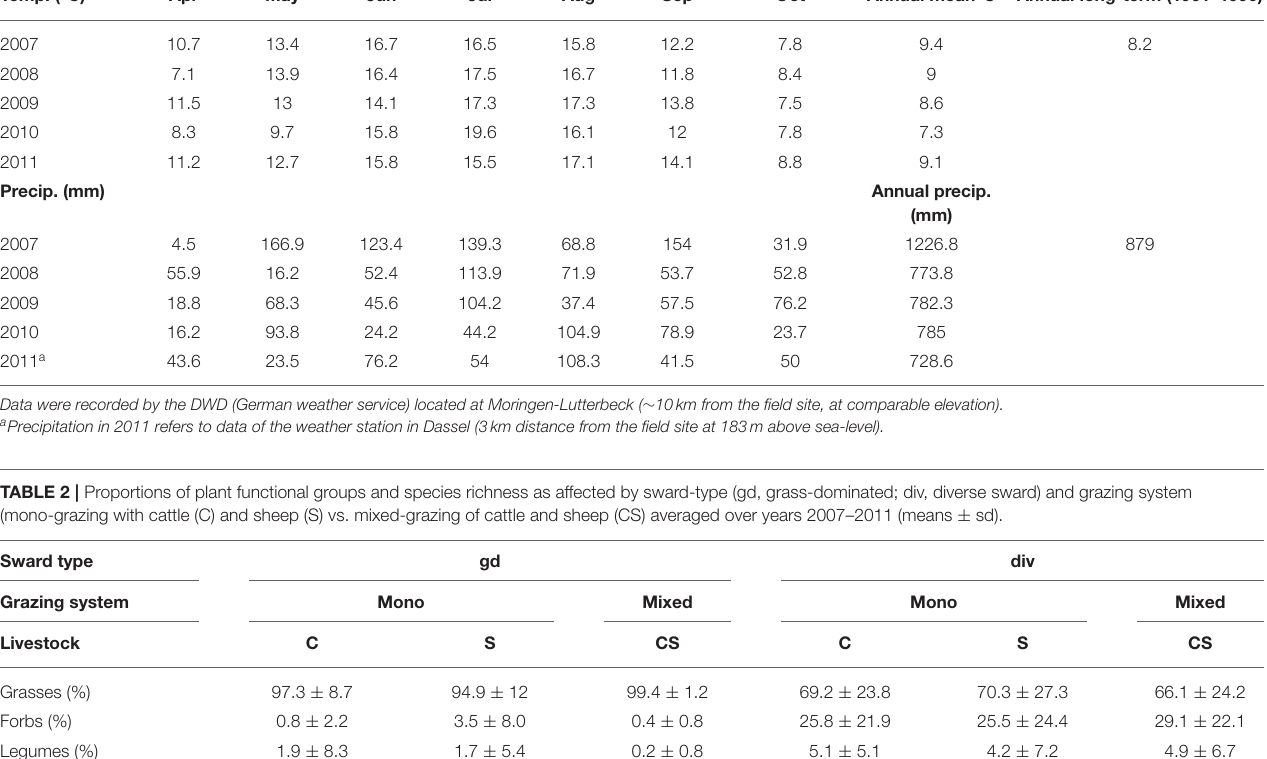
TABLE 1 | Annual and monthly mean temperatures ( ◦ C) and precipitation sums (precip., mm) between April and October for the grazing seasons 2007 until 2011 compared to long-term averages (1961–1990). Temp. ( ◦ C)